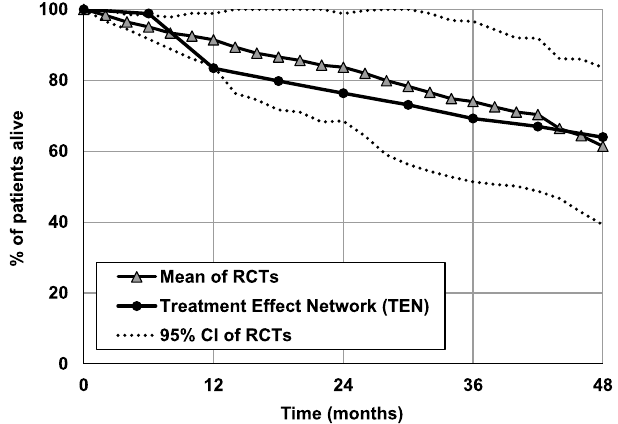
Figure 6. Probability of survival in treatment-naïve patients with CLL treated with purine analogs. Comparison of the probability predicted by the Treatment Effect Network and calculated based on results of RCTs 40–44 . The dotted lines indicate 95% confidence intervals (95% CIs).